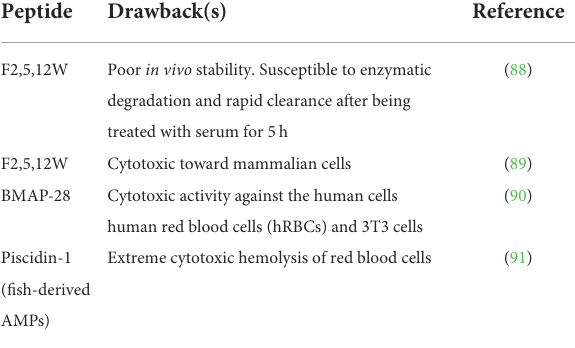
TABLE 2 Examples of bioactive peptides with in vivo